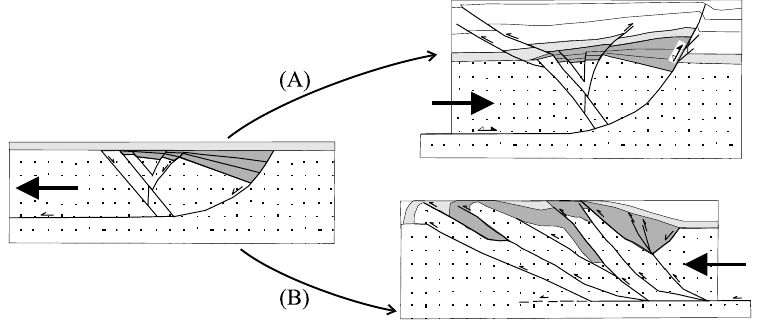
Fig. 2 – Conceptual cartoon showing (A) the classical scheme of hanging wall block inversion (McClay and Buchanan1992), and (B) the authors’ idea of the southern Serra do Espinhaço footwall block inversion. Arrows indicate sense of displacement of the moving